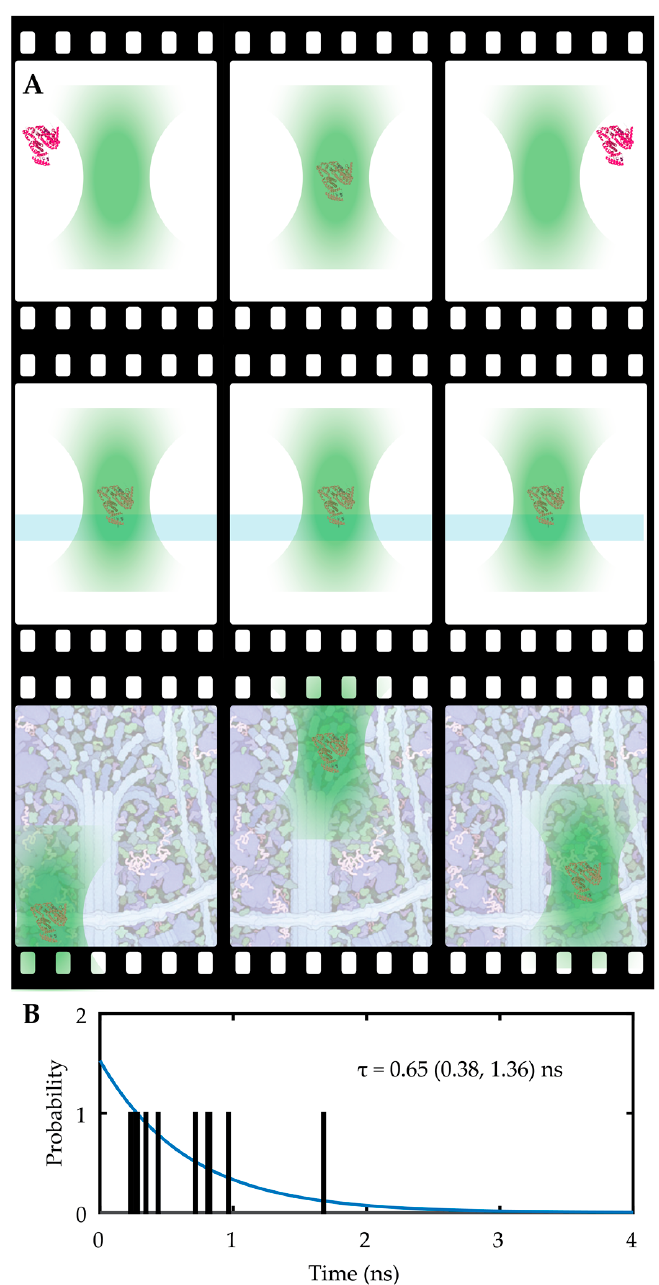
Figure 2. ( A ) Top row: The solution-phase single molecule observation limits measurement time to the di ff usion time in the laser focus. Middle row: Tethering to the coverslip extends the observation time but precludes translation to live-cell studies. Bottom row: Real-time 3D single molecule tracking spectroscopy potentially enables continuous observation of freely di ff using proteins in the cellular interior. ( B ) An example of a simulated lifetime of a single fluorophore labelled protein di ff using through a confocal volume, emitting on the order of 10 photons, yielding a large experimental error. The most productive single molecule spectroscopy methods have been those which overcome this limited information barrier by tethering or localizing the molecule in some way. Tethered molecules can then be measured with low throughput and high temporal resolution using a